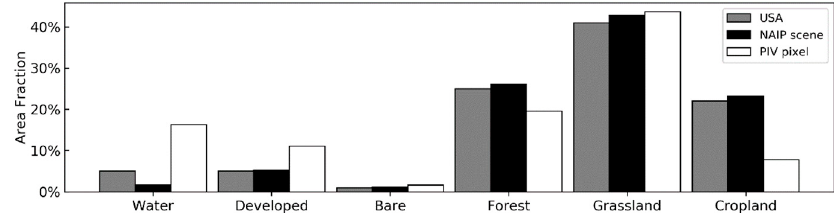
Figure 10. Comparison of average land cover conditions of NAIP images and PIV pixels for 150 sites.